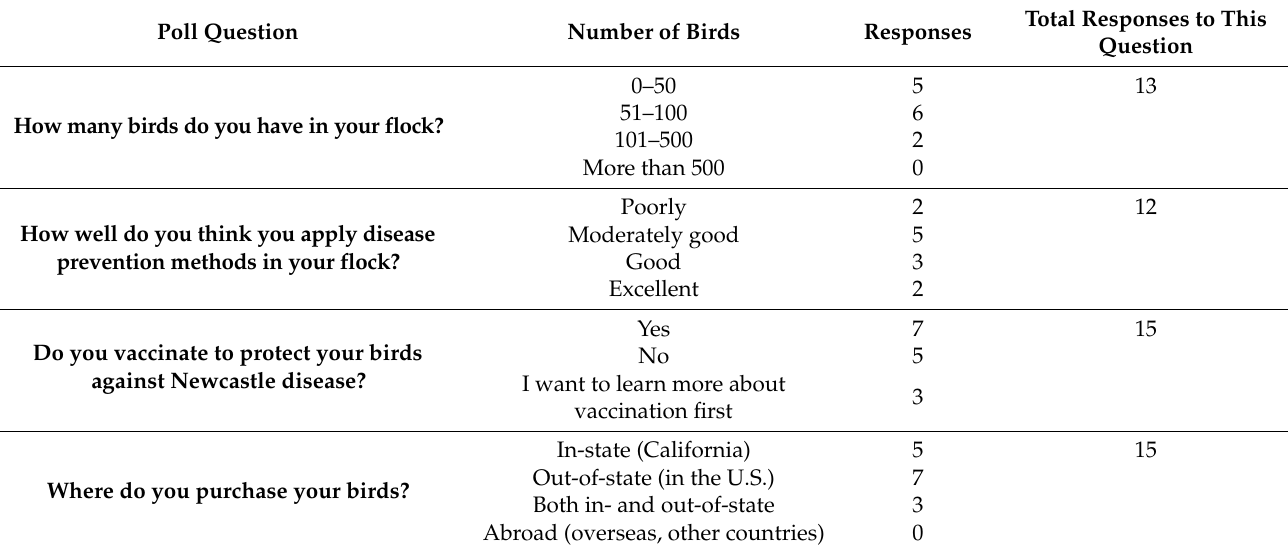
Table 1. Virtual workshop poll answers from gamefowl